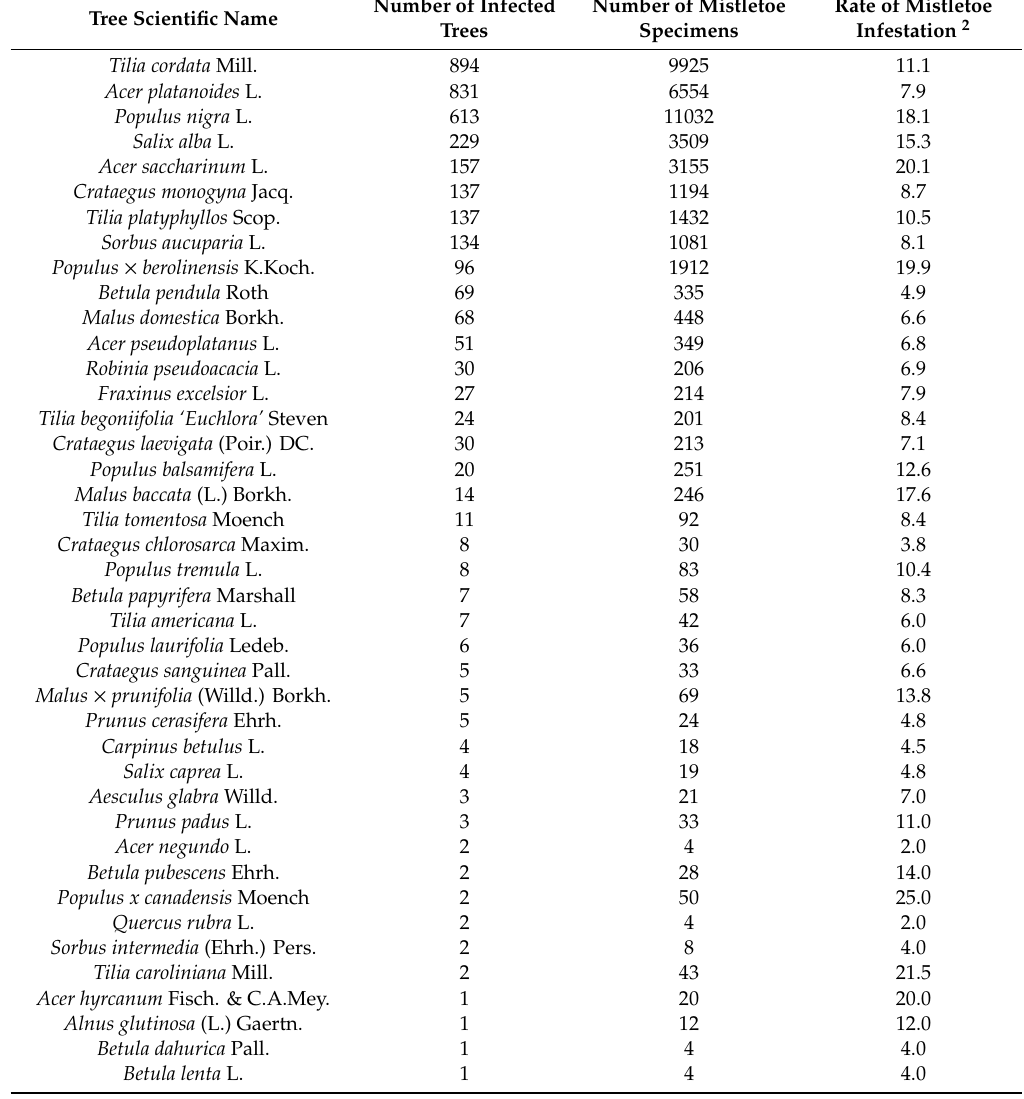
Table 1. Hosts of European mistletoe in the city of Kaliningrad 1